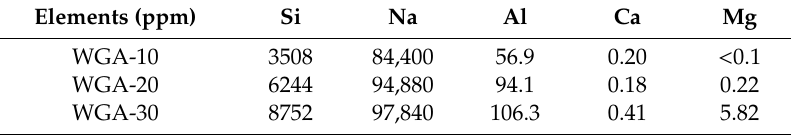
Table 3. Elemental composition of waste glass-based alkaline solution (WGA).